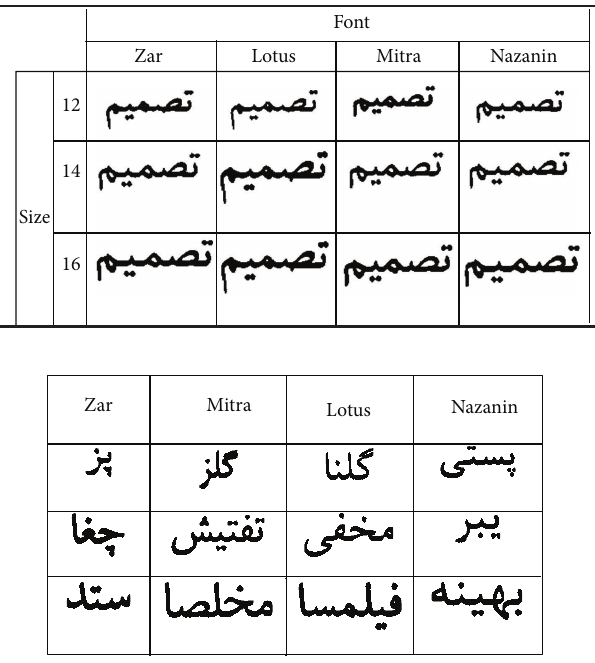
Figure 3: Sample of printed Farsi